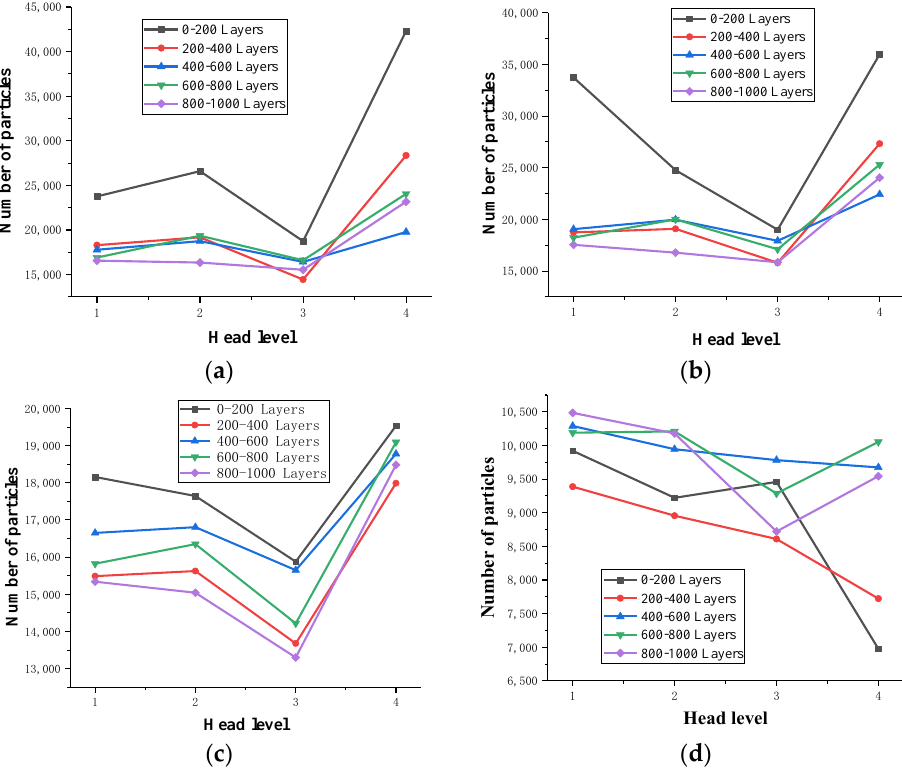
Figure 15. Variation in the number of fine particles percolated with the 50% fine content. ( a ) Particle size: 0 – 10 µm; ( b ) Particle size: 10 – 20 µm; ( c ) Particle size: 20 – 40 µm; ( d ) Particle size: 40 – 75 µm.